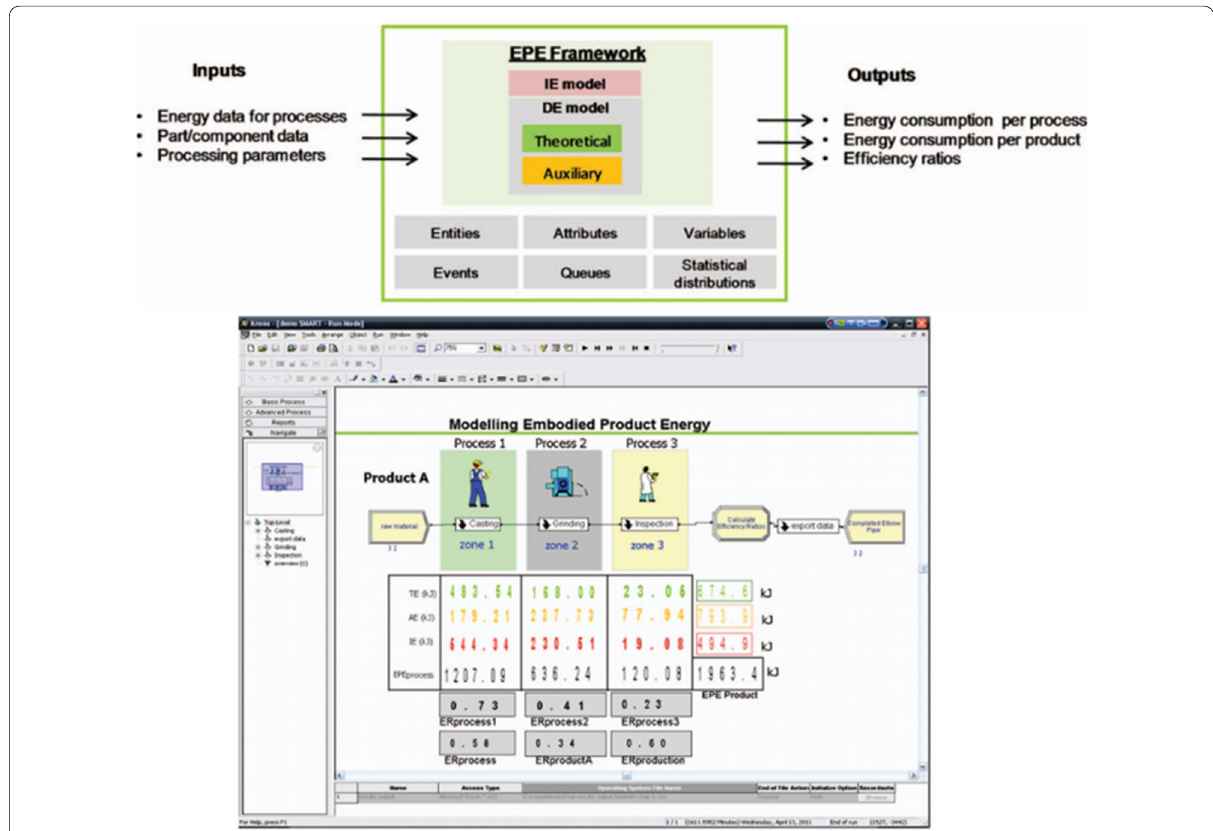
Figure 5 Energy consumption simulation model and system in manufacturing process